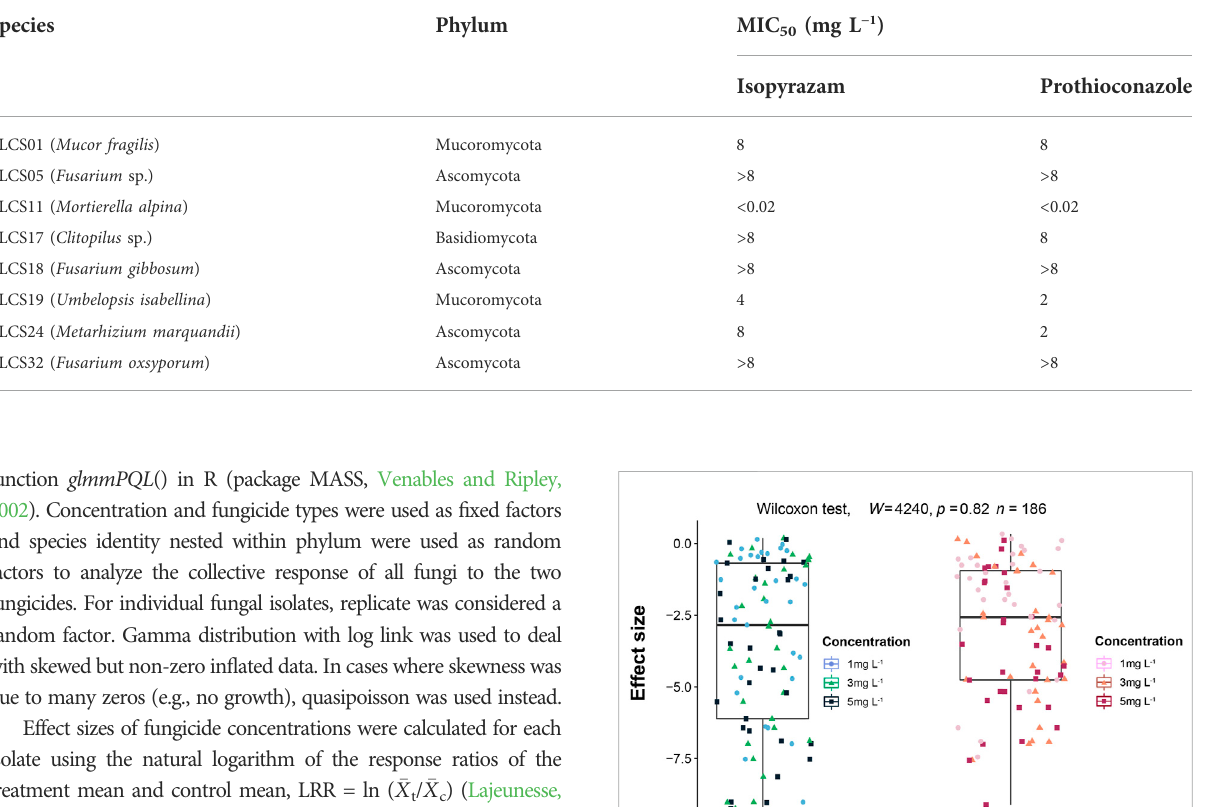
TABLE 1 Minimum inhibitory concentrations (MIC 50 ) of the representative isolates belonging to three different phyla.